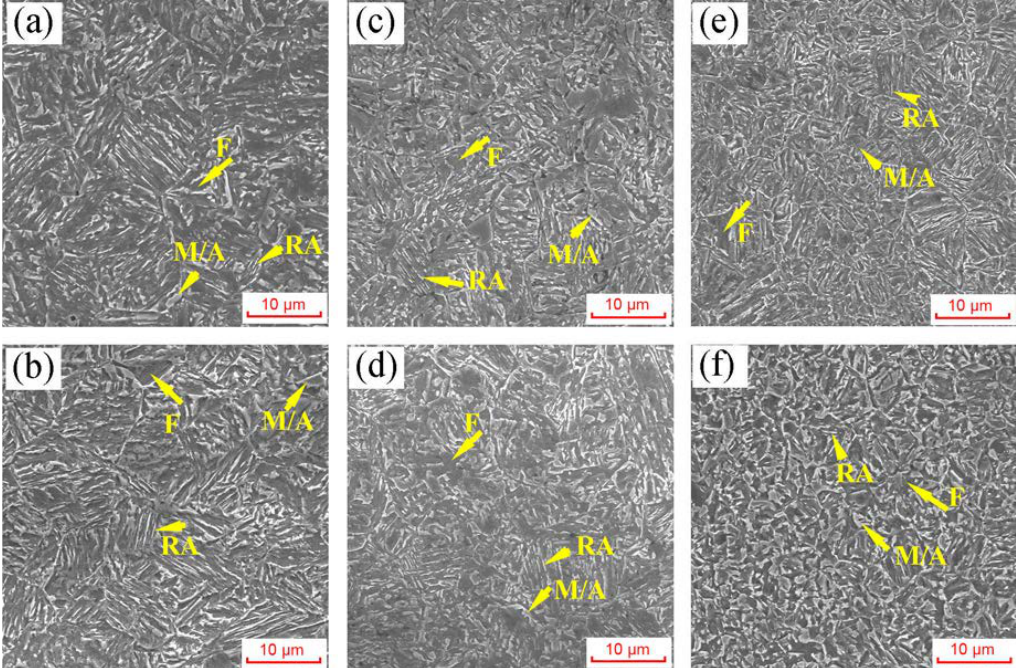
Figure 8. SEM micrographs of three steels after two-step Q&P treatment: ( a , b ) 0V, ( c , d ) 0.03V, and ( e , f ) 0.16V, partitioned for ( a , c , e ) 90 s and ( b , d , f ) 200 s. (M: martensite; F: ferrite; RA: retained austenite; M/A: martensite/austenite island.)